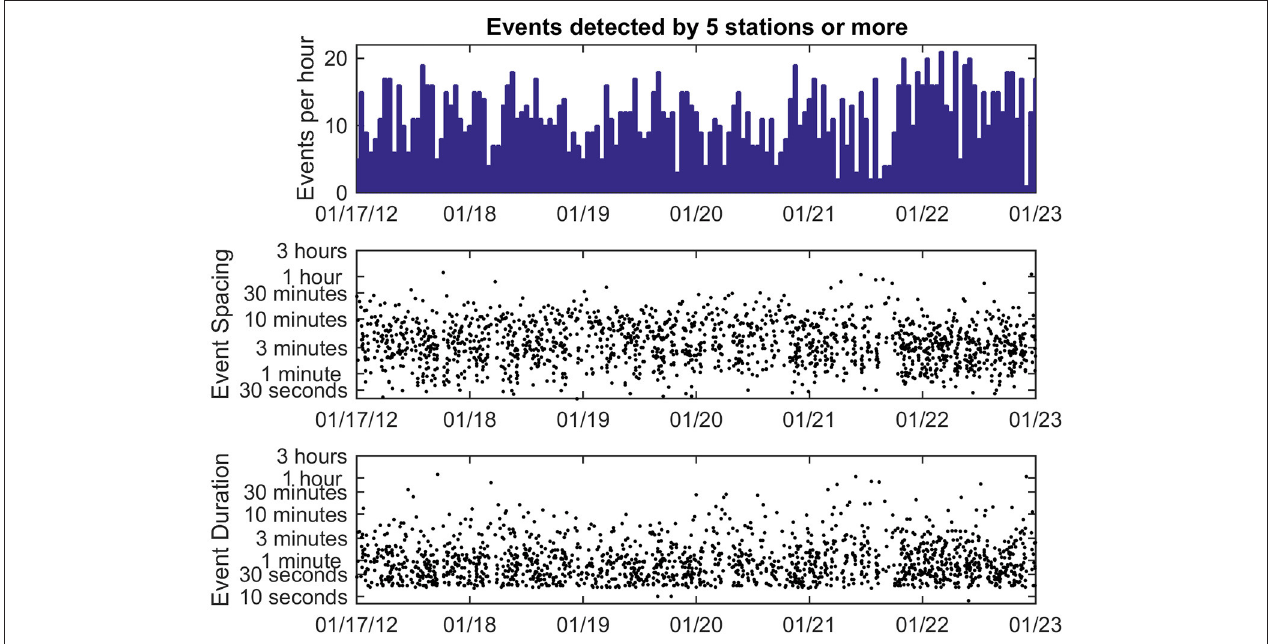
table and grouped as a “family.” The system designates the first event as a “core” event and writes it to a representative events table, which becomes important in the next step. If a new event does not correlate with any events in the current “orphan” table, it is cross-correlated with all previously identified “core” events in the representative events table. If the new event then correlates with any “core” events above the threshold, it is added to that event’s family. If not, the new event is appended to the “orphan” table. Clusters are defined using the Ordering Points to Identify the Clustering Structure (OPTICS) algorithm (Ankerst et al., 1999) which, in this usage, relies on correlation coefficients. In this implementation, an event only needs to correlate with one other event in the family to be included in the cluster; it favors fewer clusters with greater numbers of related events within each cluster family. At the same time, this algorithm identifies the event most closely correlated to all other events in the family and updates the representative event table accordingly. If the new event happens to correlate with more than one family, those family tables are merged without breaking OPTICS